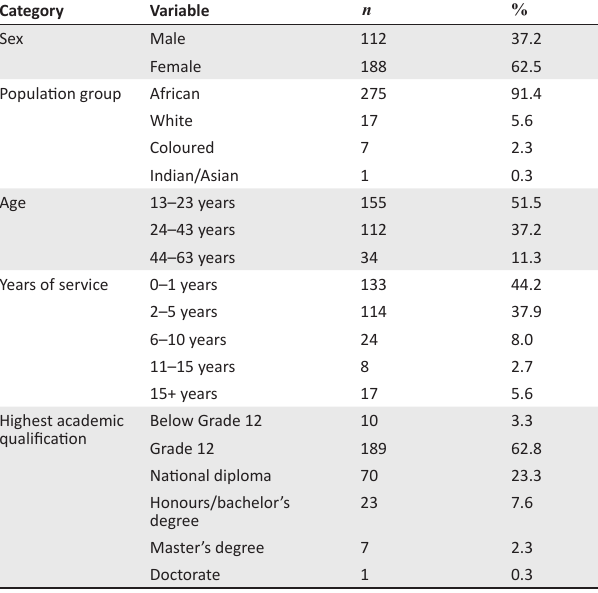
TABLE 2: Demographic profile of the sample group.